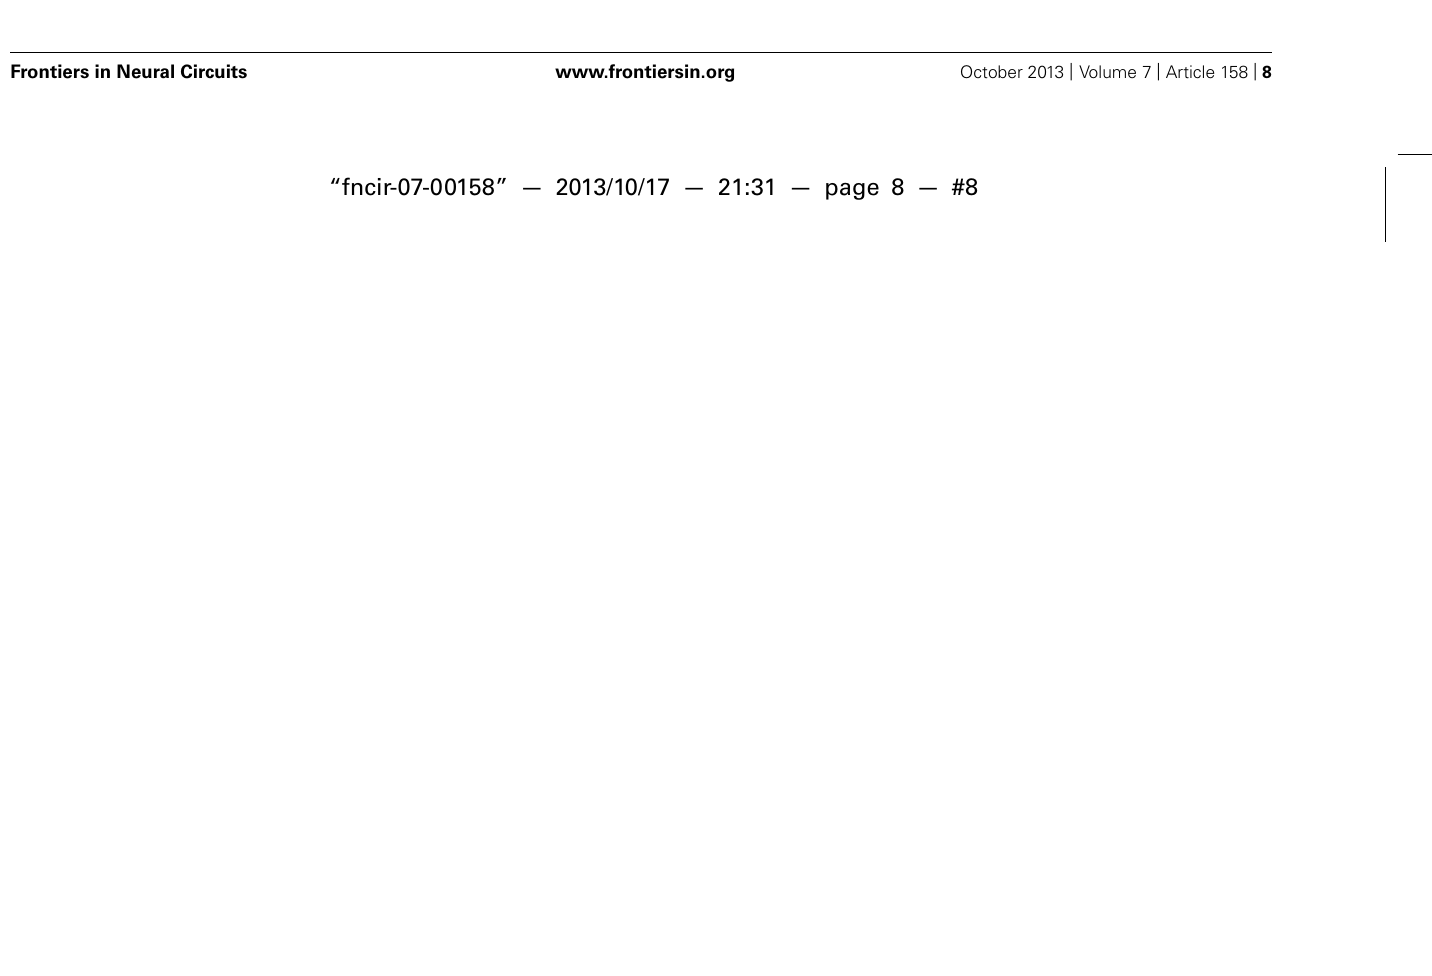
category is color coded according to the inset.The parentheses enclose the number of neurons. Green, object neurons; Blue, goal neurons; Gray, neurons selective for choice-cue location;Yellow, neurons selective for both goal and choice-cue location; Red, action neurons (adapted from Arimura etal.,